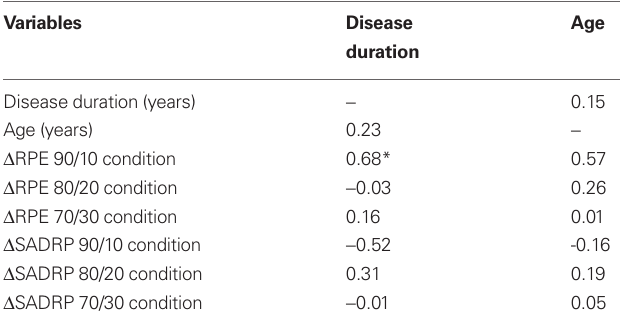
Table 2 | Correlations between ∆ SAdrP and ∆ rPe (oN compared to oFF STN stimulation) and disease duration and age.